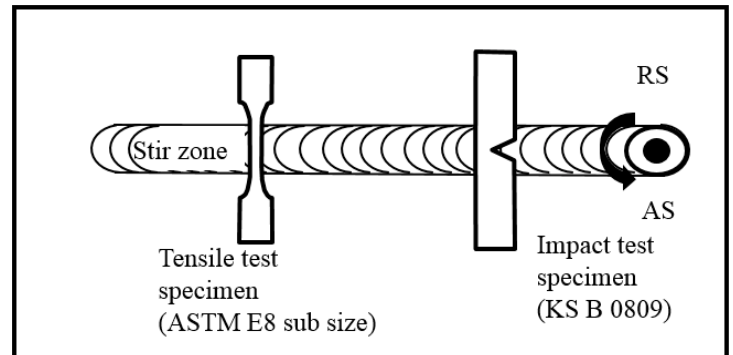
Figure 2. Schematic illustration of the friction-stir-welded plate and test specimen preparation.